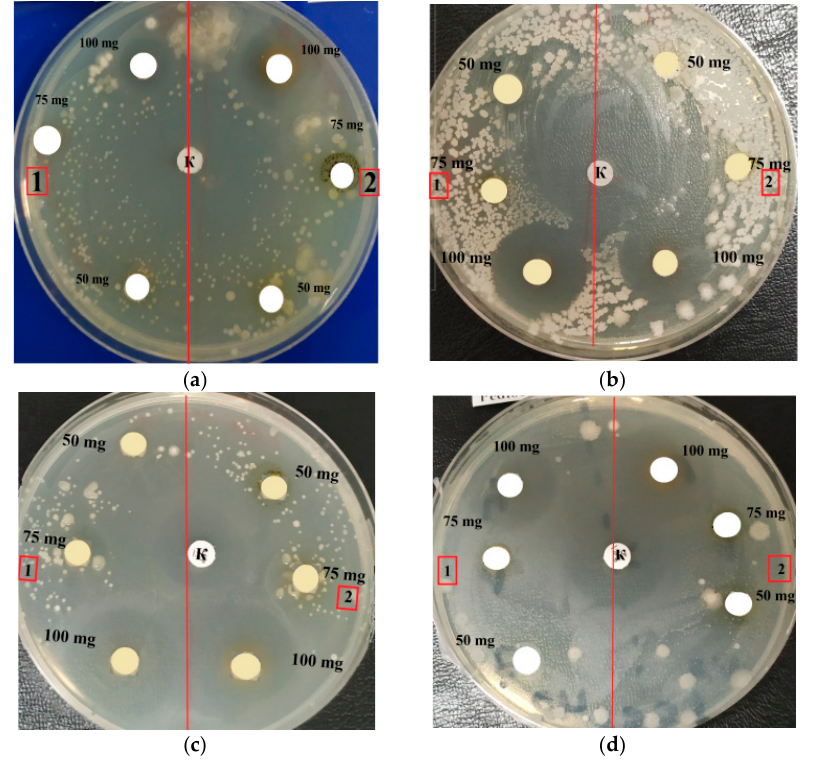
Figure 3. Inhibition zones ( а ) E. coli ; ( b ) L. mesenteroides ; ( c ) B. pumilus ; ( d ) P. pentosaceus : 1— A. platen- sis ; 2— С . vulgaris